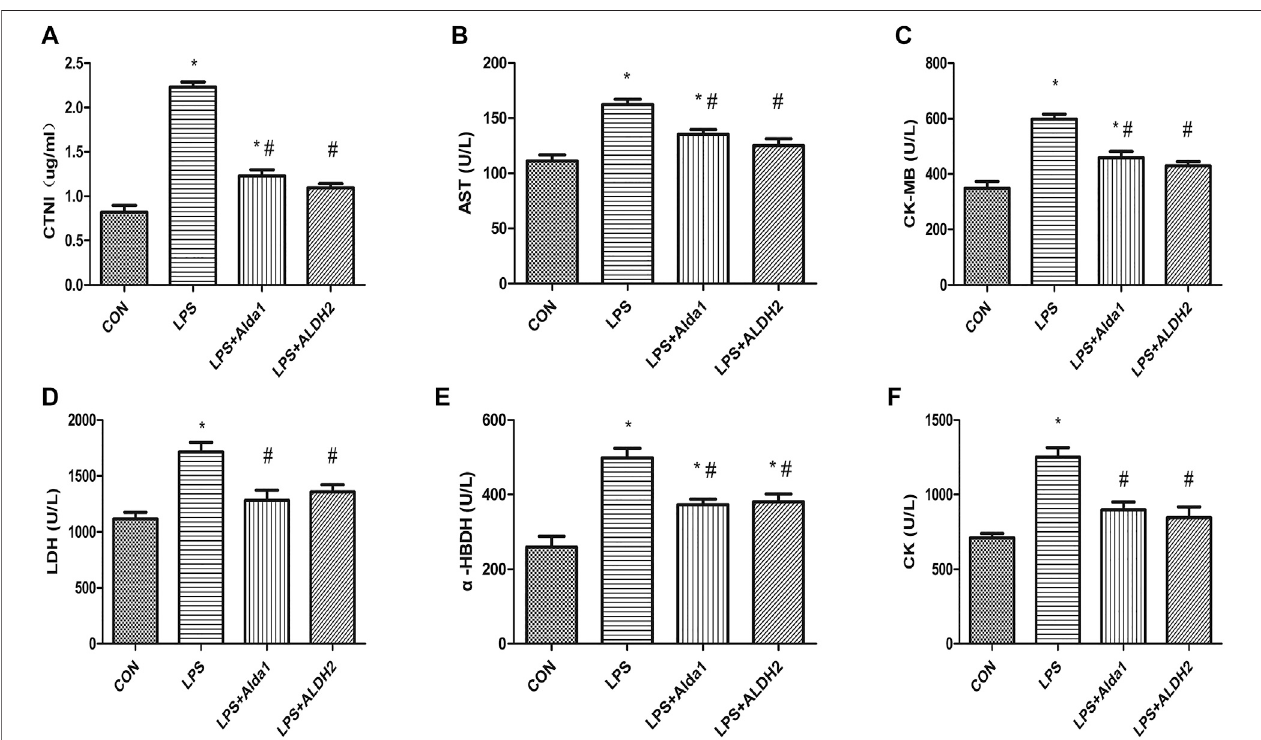
FIGURE3| Biochemicalmarkersofmyocardialinjuryinlipopolysaccharide(LPS)-treatedmice. (A) CardiactroponinI(CTNI)levels. (B) Aspartate aminotransferase (AST), (C) Creatine kinase myocardial-bound (CK-MB), (D) Lactate dehydrogenase (LDH), (E) α -Hydroxybutyrate dehydrogenase ( α -HBDH), and (F) CK activity in serum.Dataarethemean ± standarderrorofthemean. n (cid:1) 3mice/group.Statisticalanalyseswereperformedbyone-wayanalysisofvariance,followedbyTukey ’ s post hoc test for multiple comparisons. * p < 0.05 vs. control (CON); # p < 0.05 vs.